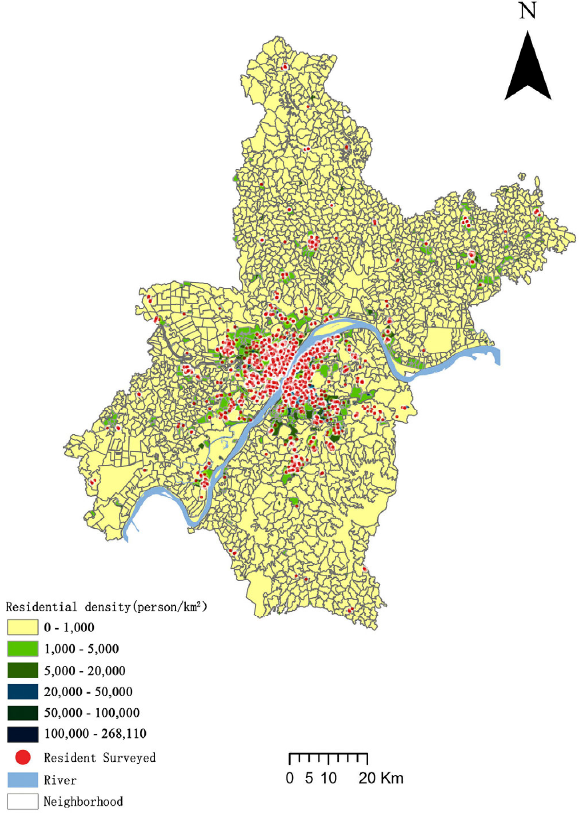
Figure 1. Spatial distribution of the residents surveyed.